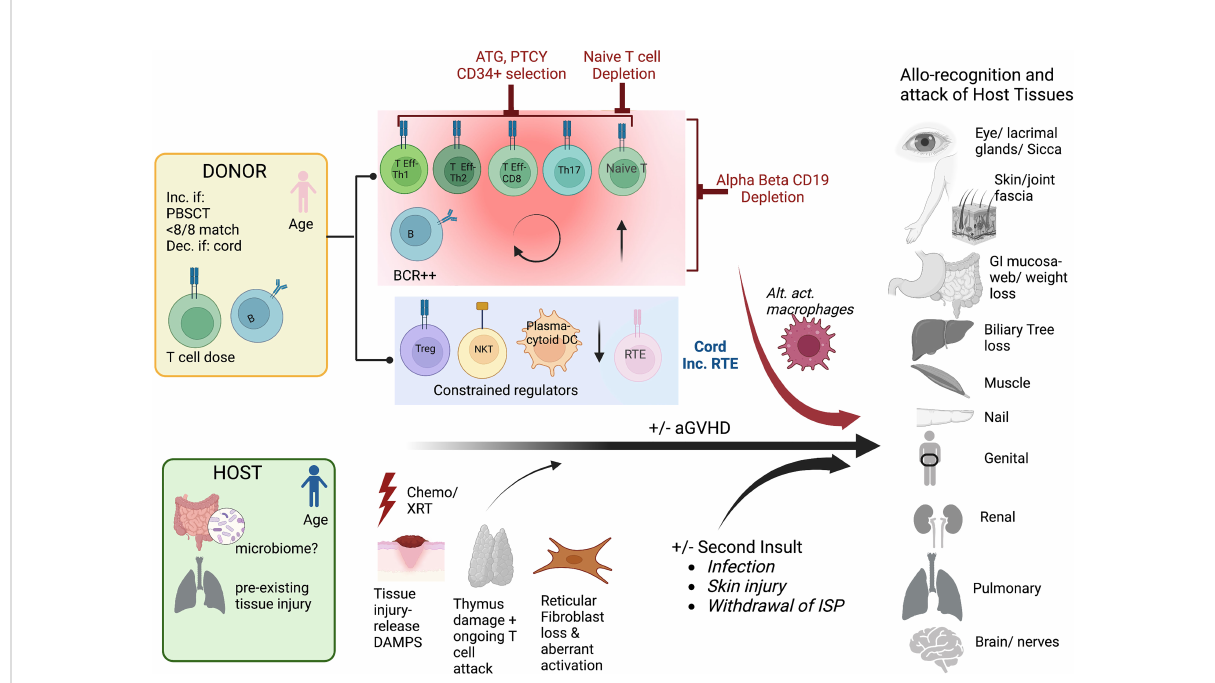
FIGURE 2 Mechanisms of cGVHD Schema of the contributions to chronic GVHD after hematopoietic cell transplantation The pink donor and blue recipient represent the gender mismatch (female to male); <8/8 match= not fully HLA matched donor/recipient pair, PBSCT= peripheral blood stem cell source, dec. if cord= decreased if cord blood source used, T cell dose= higher T cell doses and B cells are linked to more cGVHD. For the host, the microbiome may potentially play a role in addition to pre-HCT organ injury. The key contributing T cell populations are shown (T Eff-Th, T effector helper cell), Treg, T regulatory cell; RTE, recent thymic emigrants; DAMPS, danger-associated molecular patterns; alt. act. Macrophages, alternatively activated macrophages. The fi gures were generated by the authors using